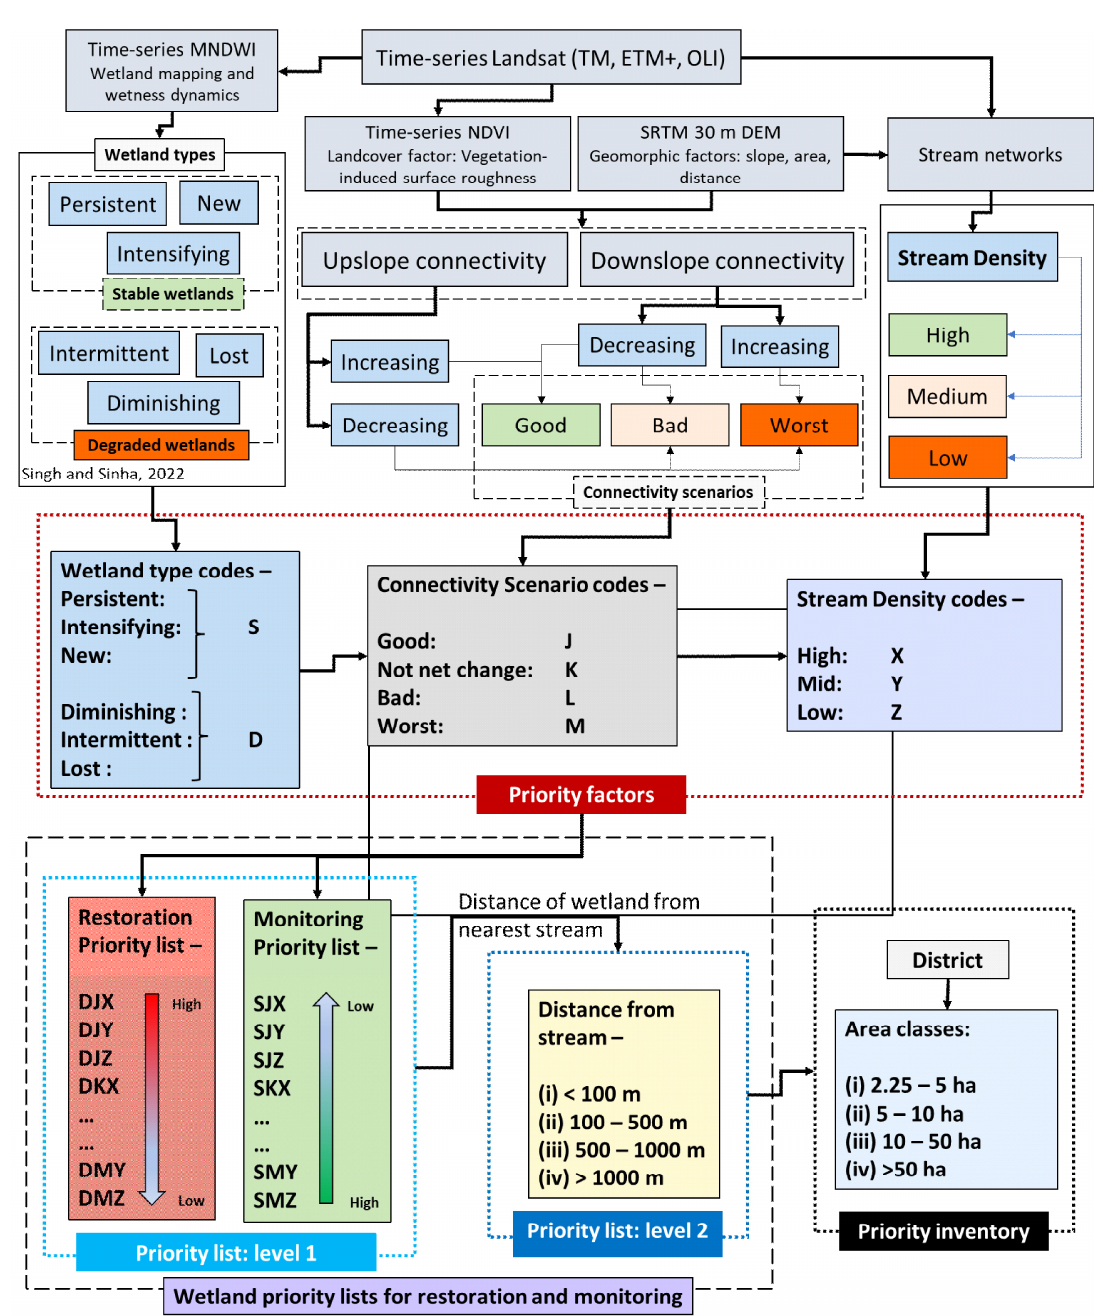
Figure 2. Flowchart of the overall methodology followed to generate the priority list of wetlands. Wetland location and their types are taken from Singh and Sinha (2021). Landsat time series period is 1994–2020 for the post-monsoon months (Oct–Nov). MNDWI: modified normalised difference water index; NDVI: normalised difference vegetation index. When both upslope and downslope connectivity increase, the resultant connectivity scenario is ‘no net change’—not shown in the flowchart.